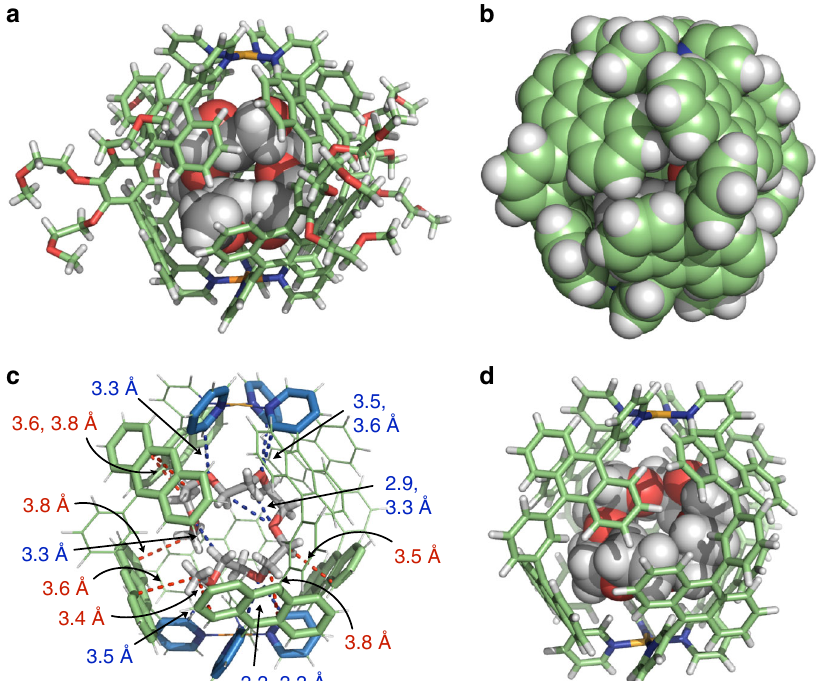
Fig. 3 Crystal and optimized structures of host – guest complexes 1 (cid:129) 5EO and 1 (cid:129) CE , respectively. a X-ray crystal structure of 1 (cid:129) 5EO and b its space- fi lling representation (the peripheral substituents of 1 are replaced by hydrogen atoms for clarity). c Highlighted host – guest and guest-guest interactions of 1 (cid:129) 5EO in the cavity (red and blue dashed lines are CH- π and hydrogen-bonding interactions, respectively). d Optimized structure of 1 (cid:129) CE (the peripheral substituents of 1 are replaced by hydrogen atoms for